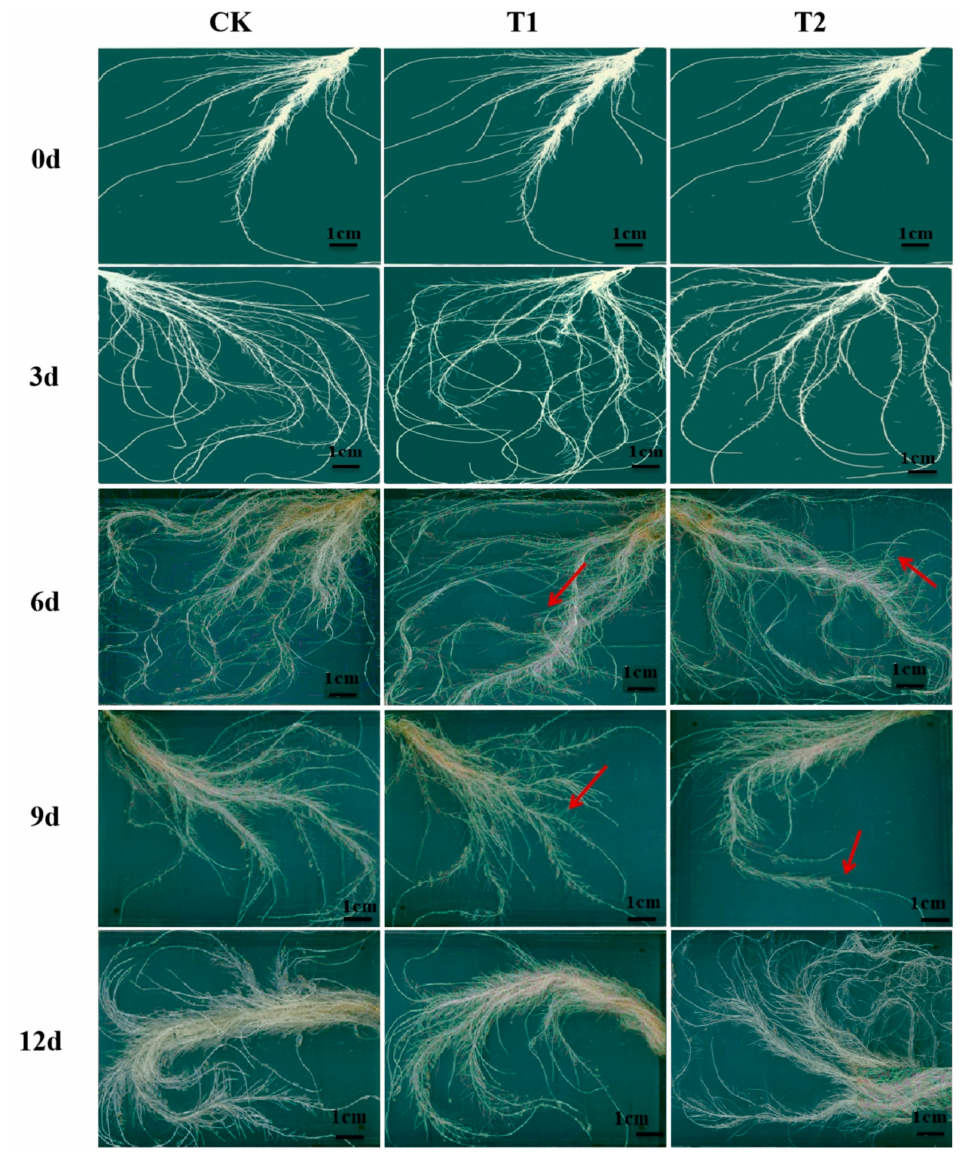
Figure 1. E ff ect of root-zone CO 2 concentration on root morphology. Root morphology of oriental melon seedlings on day 0, 3, 6, 9, and 12 of high concentration rhizosphere CO 2 treatment. Scale bar: 1 cm. The red arrows in the picture indicated that, the root growth under T1 and T2 treatment were not significantly di ff erent at 6 day, compared with plants under CK (control check, ambient air 0.037%); on the ninth day, the root length, root surface area, and the number of major absorbing roots under T1 and T2 treatments were remarkably lower than in the CK